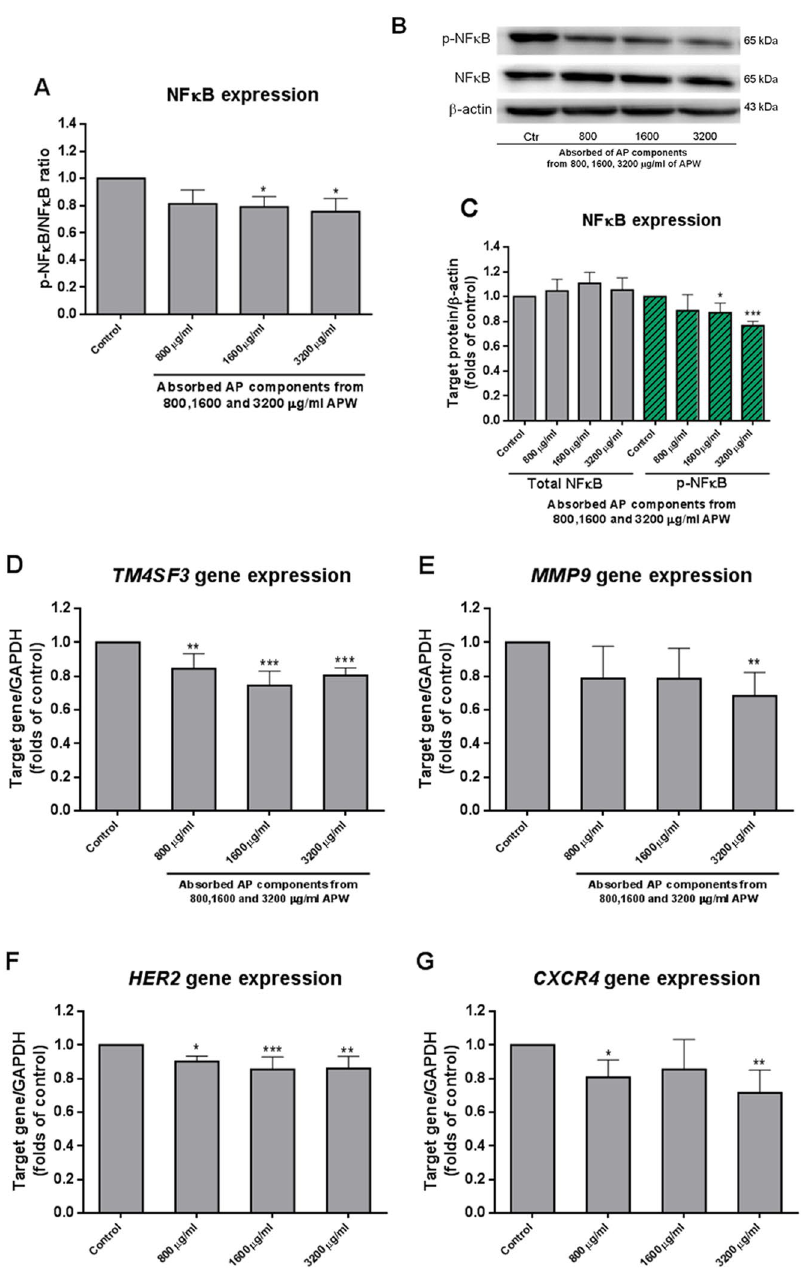
Figure 3. Effect of absorbed AP components from 800, 1600 and 3200 μ g/ml APW on NF κ B expression and the expression of metastasis-related genes. ( A ) NF κ B ELISA assay. The OD values were normalised with the corresponding protein concentrations. Each column represents the mean + S.D. in duplicates of three independent experiments. ( B ) Western blot analysis of p-NF κ B and NF κ B expression. Representative immunoblots showing the effects of absorbed AP components from 800, 1600 and 3200 μ g/ml APW on EC- 109 cellular expression of p-NF κ B and NF κ B. Actin expression was determined to confirm equal protein loading. ( C ) The histogram showed quantified results of protein levels, which were adjusted with corresponding β -actin protein level and expressed as folds of control (mean fold of control + S.D. of three independent experiments). Differences between the treatment groups and the control group were determined by one way ANOVA followed by post-hoc Dunnett’s test, * p < 0.05, *** p < 0.001 as compared with vehicle control. ( D – G ) Real-time PCR showed the expression of metastasis-related genes. EC-109 cells were treated with absorbed AP components from 800, 1600 and 3200 μ g/ml APW for 24 h and then the cells were collected for RNA extraction. Quantitative real time PCR analyses of mRNA of TM4SF3 , MMP9 , HER2 and CXCR4 genes were shown. Data were normalized to corresponding GAPDH expressions as internal control. The results of mRNA expressions are expressed as fold of control (mean fold of control + S.D. from 3 independent experiments). Differences among all groups were determined by one-way ANOVA followed by post-hoc Tukey’s multiple comparison test, * p < 0.05, ** p < 0.01, *** p < 0.001 as compared with vehicle